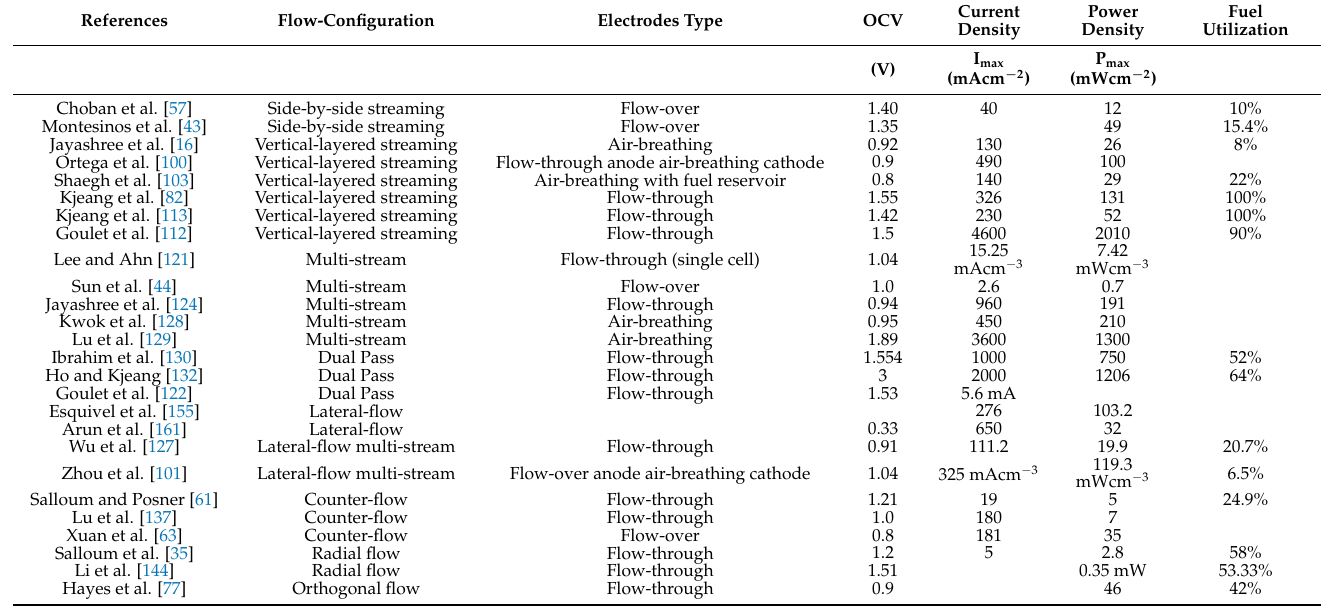
Table 3. Performance of MMFCs with different flow configurations.